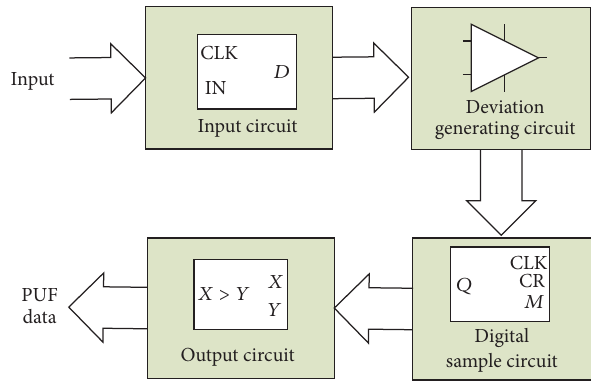
Figure 4: IM-PUF circuit